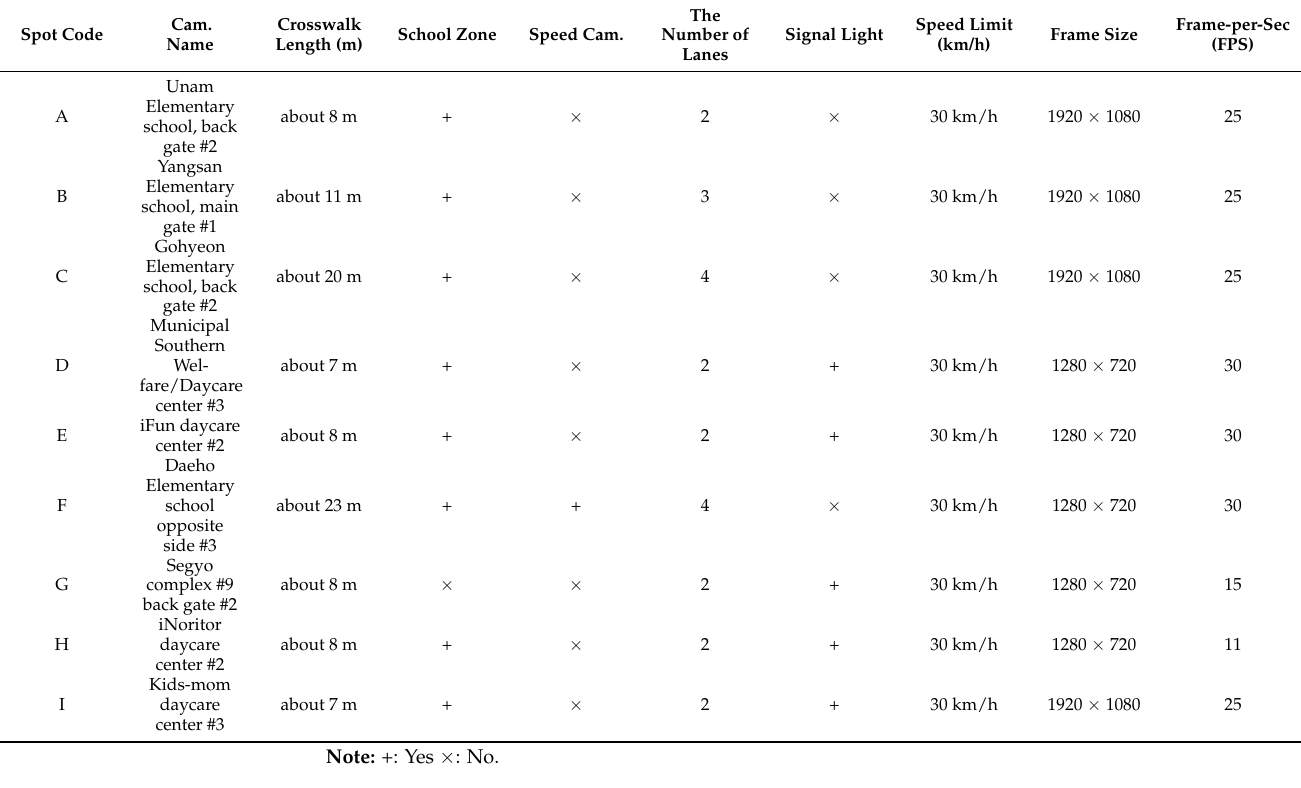
Table 1. Information of the obtained spots.